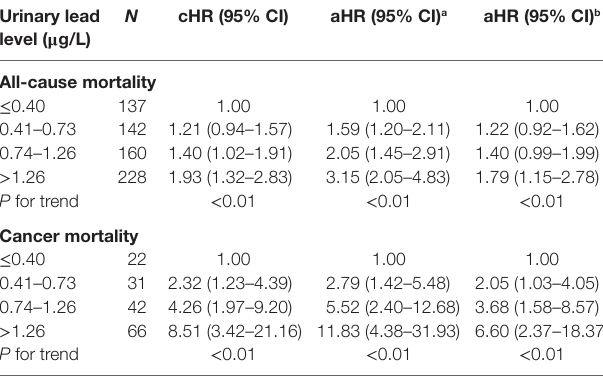
TaBle 3 | Hazard ratio for all-cause and cancer mortality by urinary lead level- NHANES 1999–2010. Urinary lead level ( μ